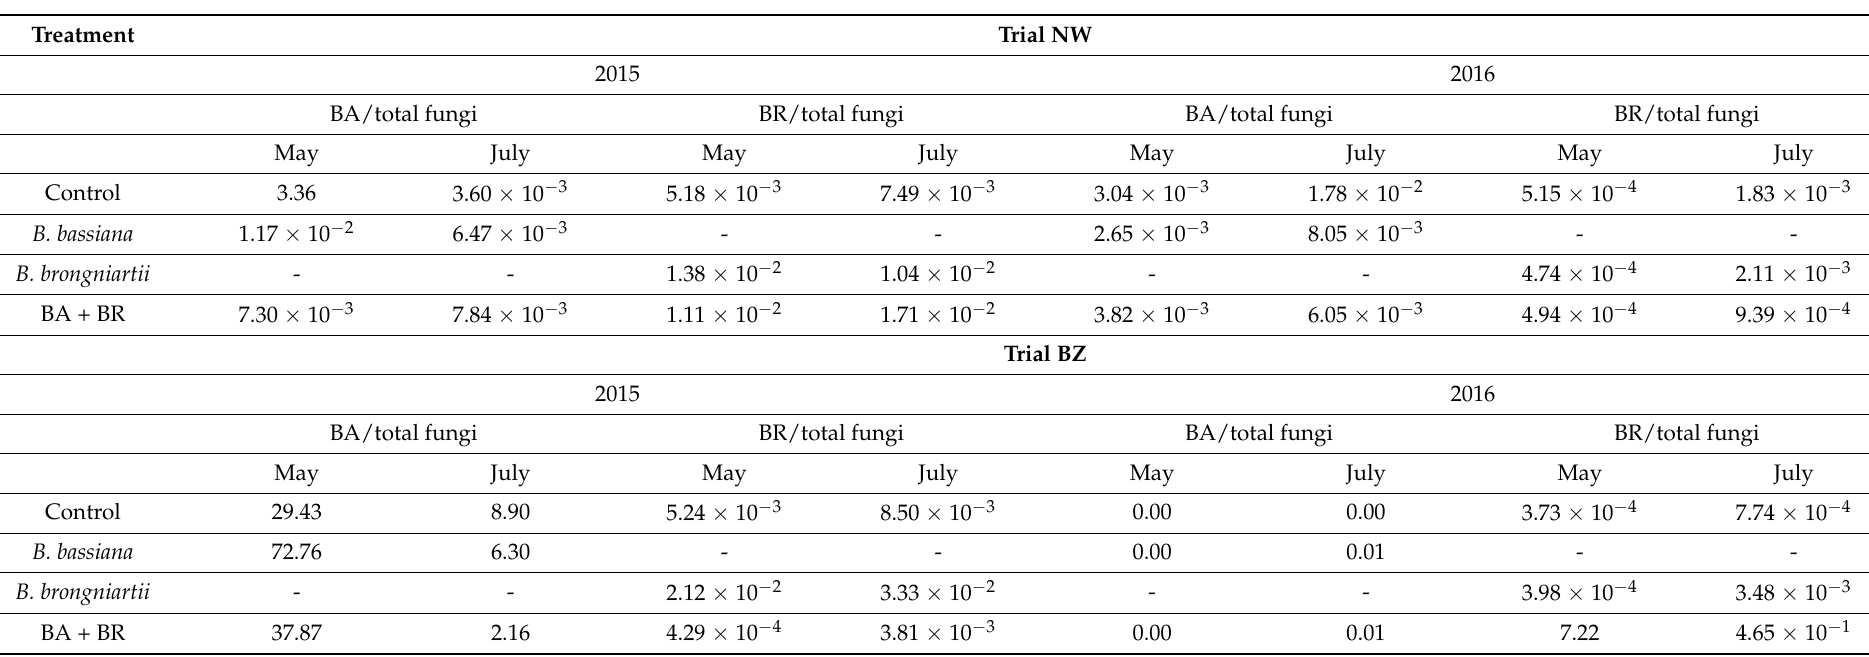
Table 4. Share of two entomopathogenic fungal species ( B. bassiana and B. brongniartii ) after application of strains of these species alone or co-inoculated (BA + BR) on the total soil fungal population determined on the basis of gene copy number